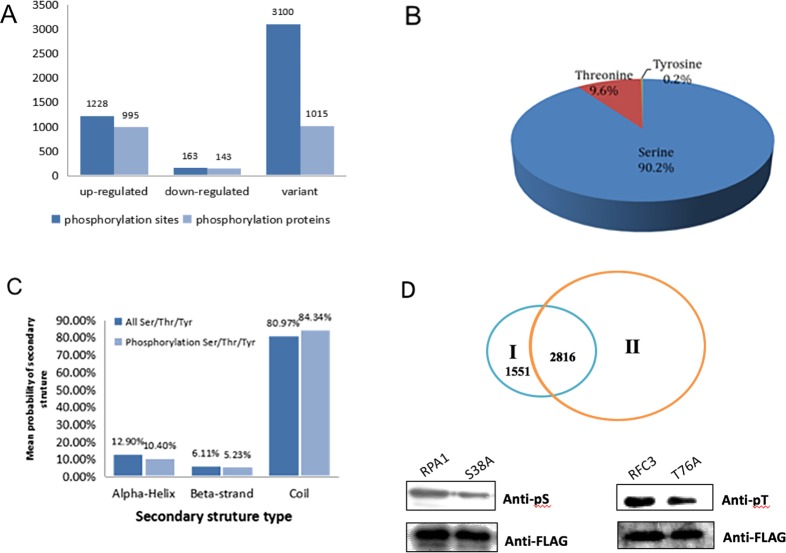
Quantitative overview of phosphorylated peptides and proteins in HeLa cells following UV treatment.(A) Number of phosphorylated proteins and proteins’sites quantified in HeLa cells in response to UV treatment. (B) Distribution of identified phosphorylated peptides at Serine, Threonine and Tyrosine sites. (C) Distribution of phosphorylated and non-phosphorylated amino acids in secondary structure. (D) Comparison of phosphorylated peptides identified in this study (I) and Phospho.ELM database (II) (http://phospho.elm.eu.org/).Validation of phosphorylation sites in RPA1 (S38) and RFC3 (T76) by western blot. Plasmids with 3xFLAG-S38A or 3xFLAG-T76A mutation were transfected to HeLa cells and precipitated by M2 beads. The phosphorylation level between wildtype and mutant proteins were evaluated by western blotting using specific antibody.